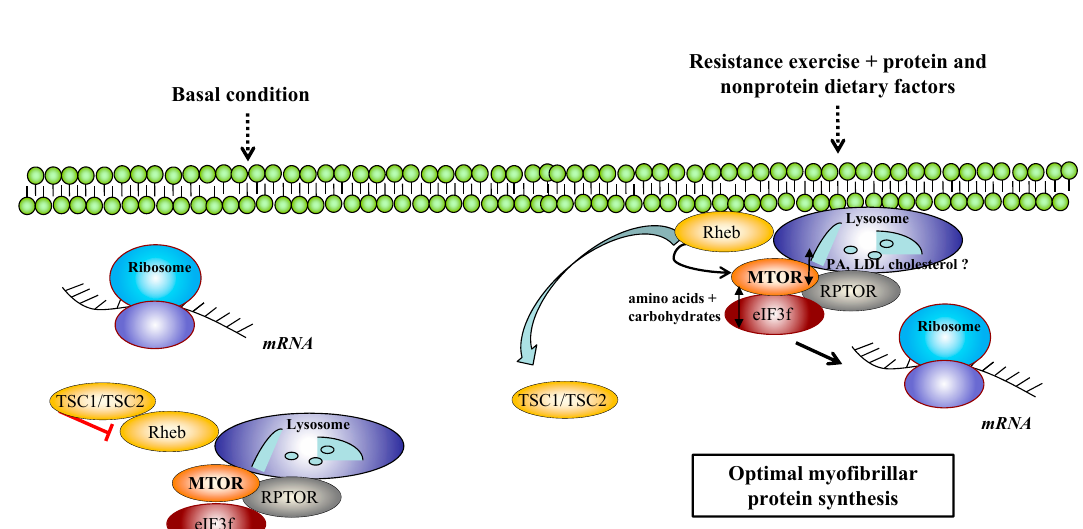
Figure 2. Cellular tra ffi cking of mechanistic (or mammalian) target of rapamycin complex 1 (MTORC1) and lysosome after resistance exercise. In response to resistance exercise, MTORC1 co-localizes with the lysosome and translocates at the cell membrane. MTORC1 recruitment to the lysosome surface is critical to increase MTOR kinase activity. Contractions lead to a decrease of tuberous sclerosis complex 2 (TSC2) abundance and, conversely, to the activation of MTOR by the GTPase Ras homolog enriched in brain (Rheb). A protein-carbohydrate beverage post-exercise increases the interaction between MTOR and eukaryotic initiation factor 3f (eIF3f) without altering MTORC1 / eIF3f translocation. Whole eggs ingestion enhances MTORC1 co-localization to the lysosome after resistance